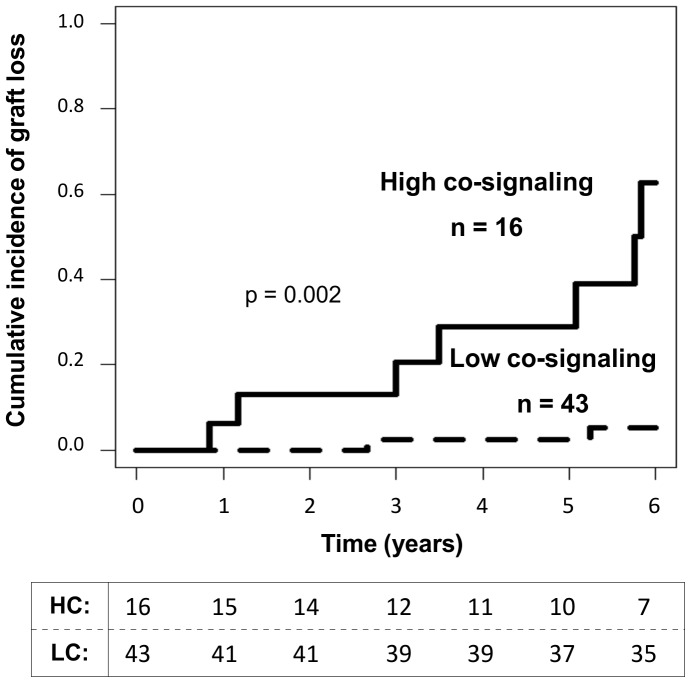
Long-term graft survival based on the determination of soluble co-signaling molecules.Patients with high levels of soluble co-signaling molecules determined at 3 months post-transplantation have a higher risk of graft failure than those with low levels (low co-signaling group) (p = 0.002). The Nelson-Aalen estimator was used to analyze the incidence of graft loss due to the existence of competing events (patients died with a functioning graft during the follow-up period). The number of patients analyzed each year, taking into account those with graft loss and those who died with a functioning graft are presented at the bottom.